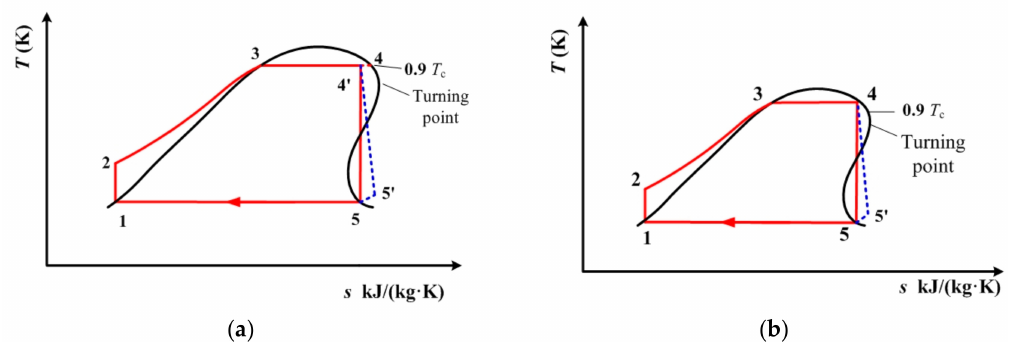
Figure 13. ( a ) Subcritical and ( b ) transcritical cycles of cis-butene when considering the isentropic e ffi ciency of the